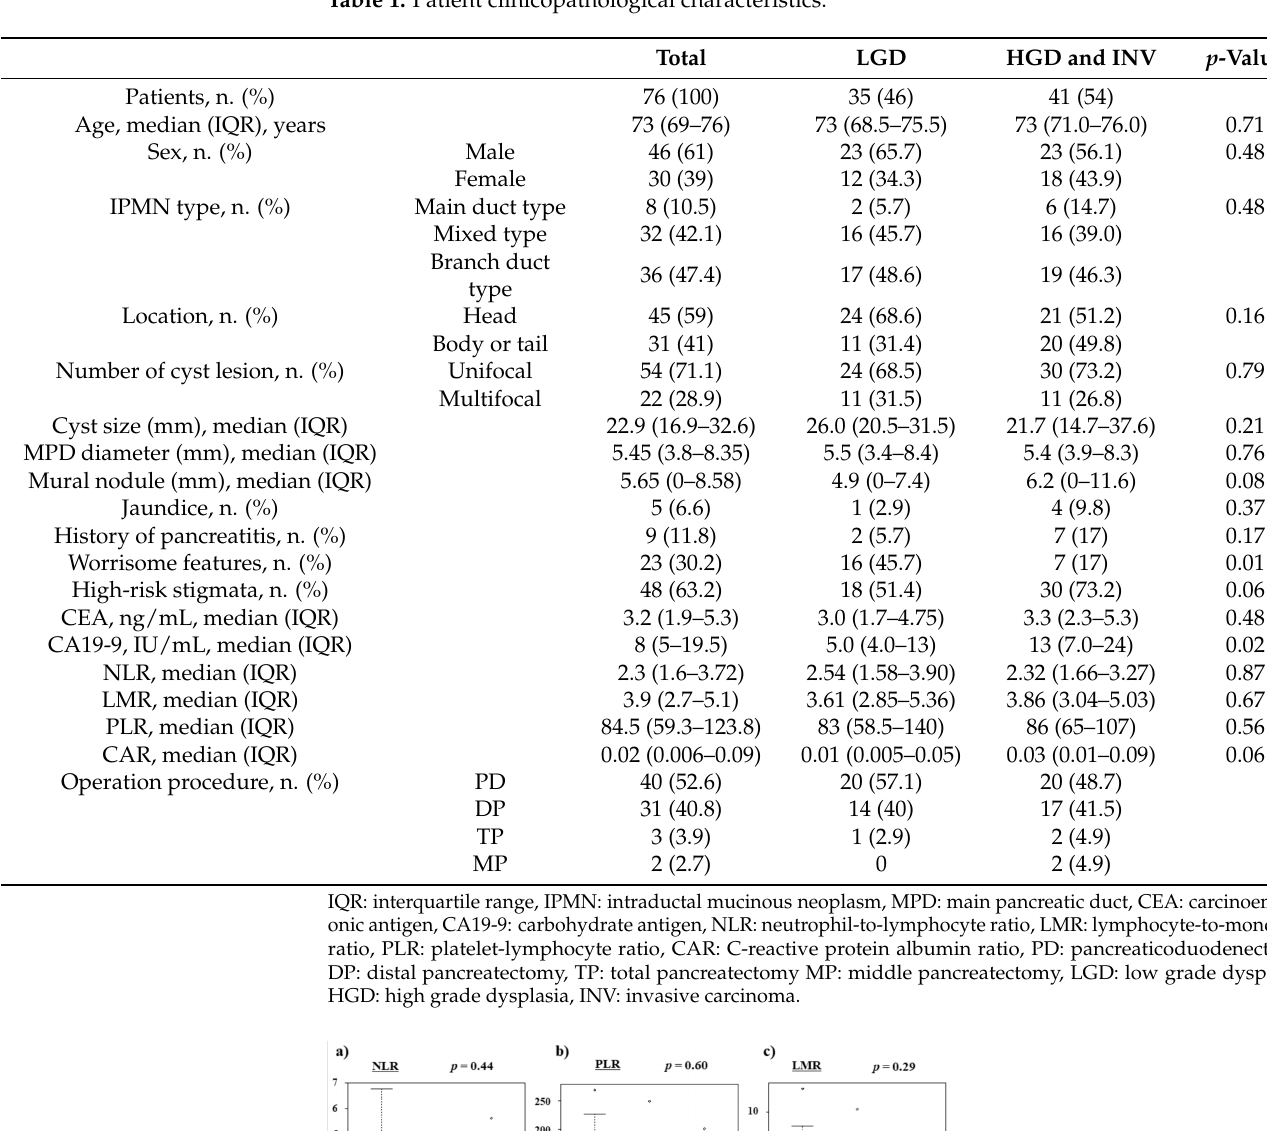
Table 1. Patient clinicopathological characteristics.